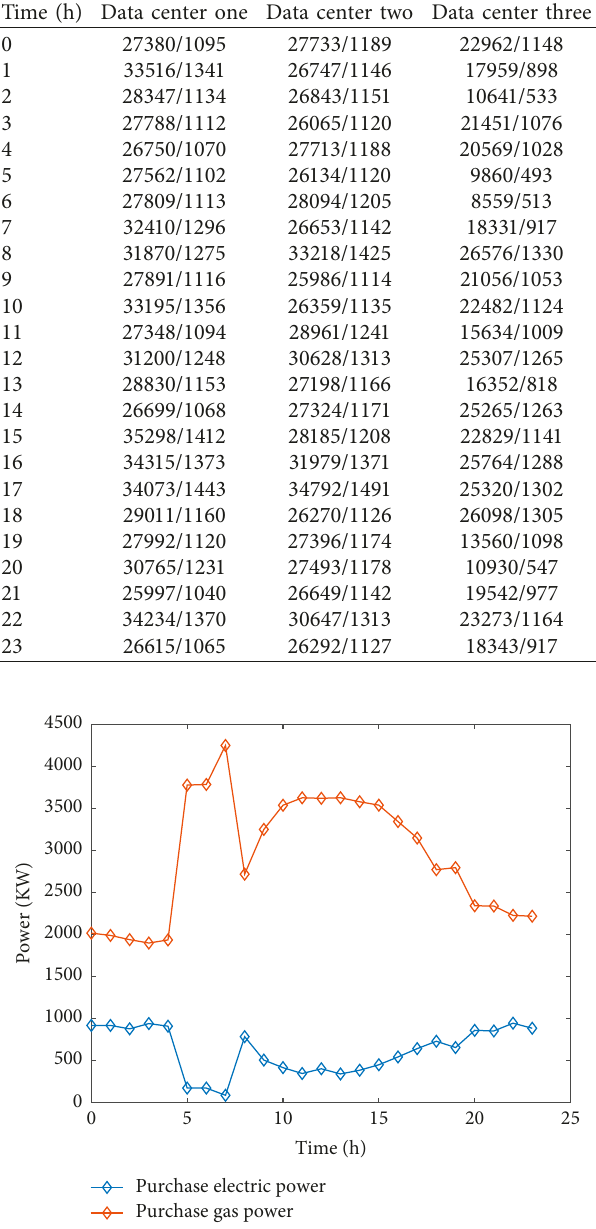
Table 6: Data center load and server allocation. Time (h) Data center one Data center two Data center three